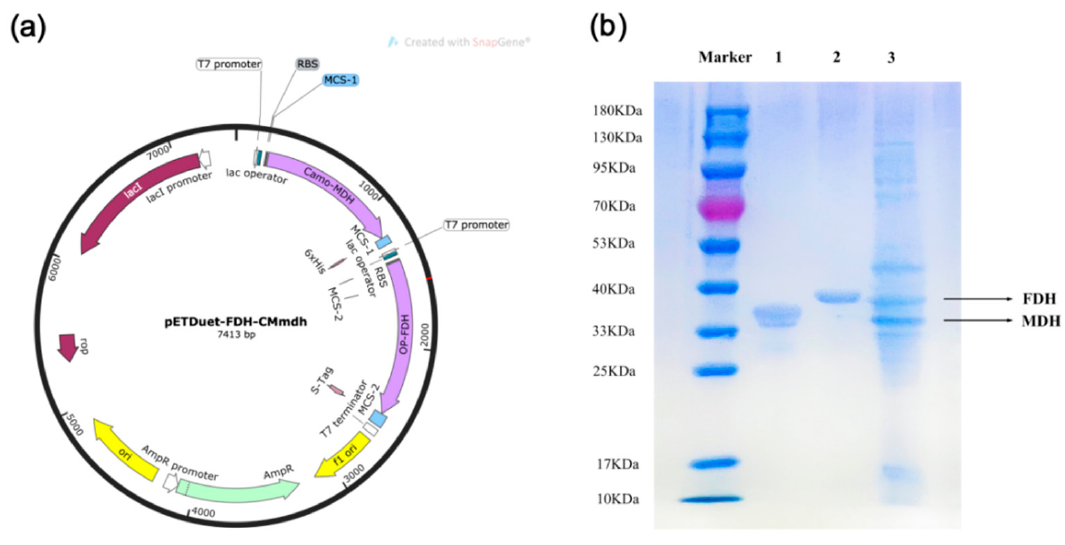
Figure 2. pETDuet-1-MDH-FDH recombinant plasmid construction map ( a ), and SDS-PAGE analysis of the purified enzymes and co-expression recombinant cells of MDH and FDH ( b ). Lane M, protein marker; lane 1, the purified enzyme of E.coli BL21(DE3)-pETDuet-1-MDH, lane 2, the purified enzyme of E.coli BL21(DE3)-pET22(b)-FDH, lane 3, the whole-cell of E.coli BL21(DE3)-pETDuet- 1-MDH-FDH.